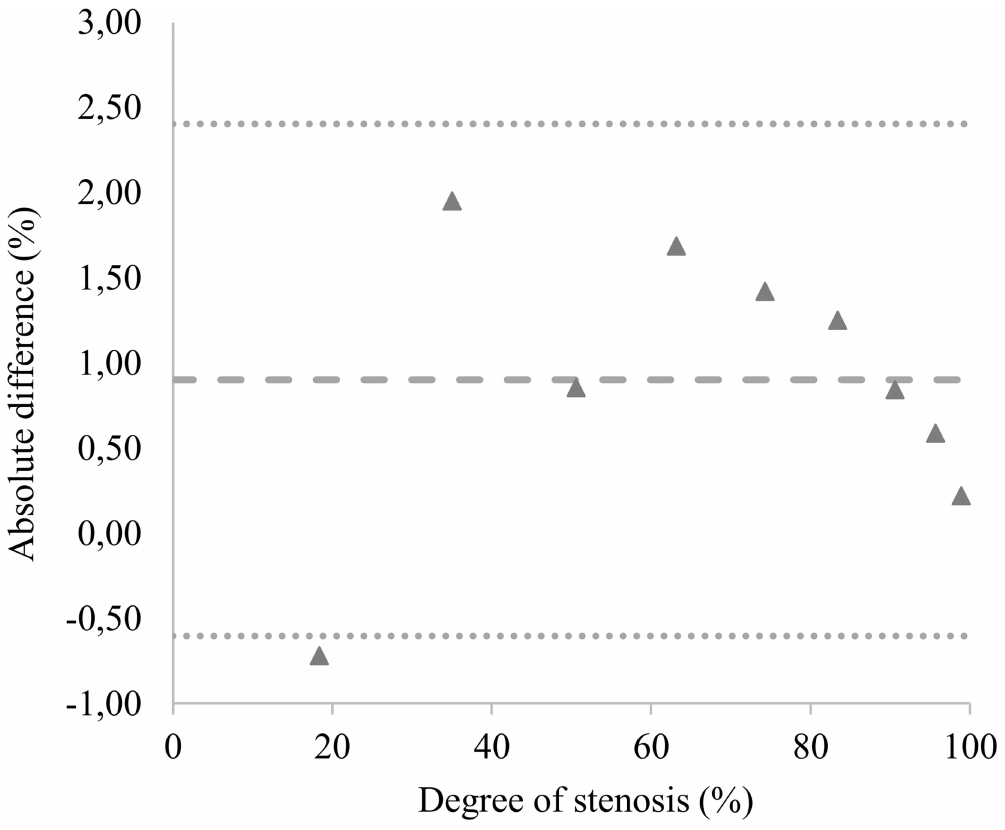
Fig 6. Bland-Altman plot of the difference of the calculated and measuredlumen loss of the reference phantom. It can be depicted that the mean absolute difference is 0.9%. Accordingly, the plot shows that there is a slight tendencyto underestimate the degreeof lumen loss. This effect diminishes with higherdegreeof lumen loss becauseof the smaller diametersof the